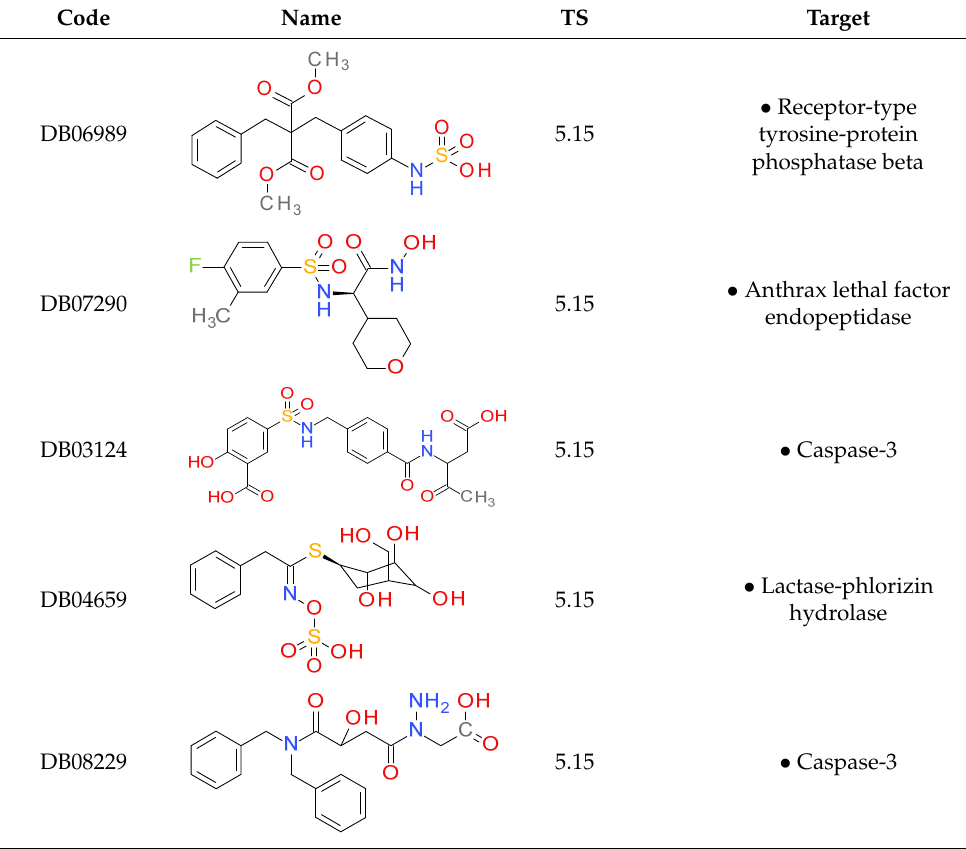
Table 6. Molecular docking simulations results for the top ranking DrugBank candidates.